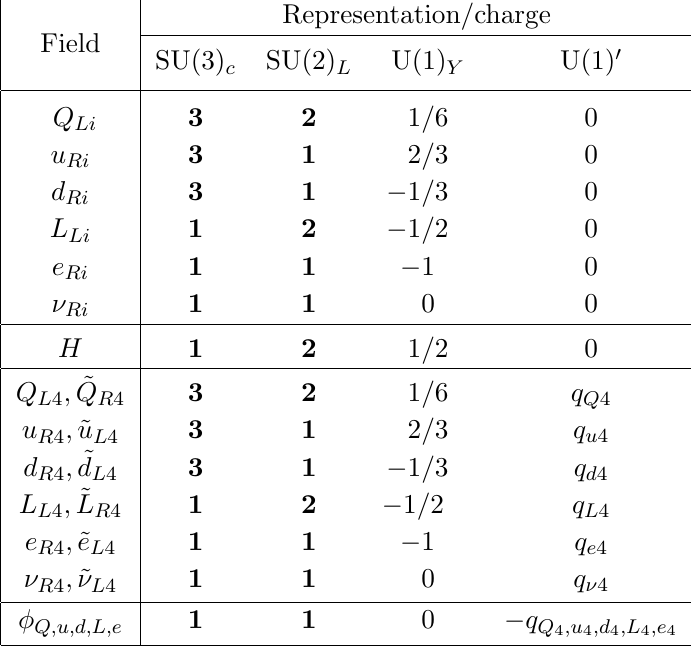
Table 1 . The model consists of the usual three chiral families of quarks and leptons i ( i = 1 ; 2 ; 3), including the right-handed neutrino, a Higgs doublet H , plus a fourth vector-like family of fermions ~ 4 ; 4 and new Higgs singlets (cid:30) which mix fourth family fermions with the three chiral families. Note that we exclude (cid:30) (cid:23) so that (cid:23) R 4 ; ~ (cid:23) L 4 do not mix and are